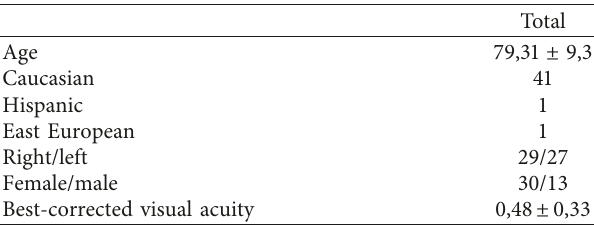
Figure 2: An example of a “merged image” obtained by using GIMP software, after overlapping a 10-2 CMP with Heidelberg IR (a) and AF (b) pictures. Table 1: Demographic characteristics of